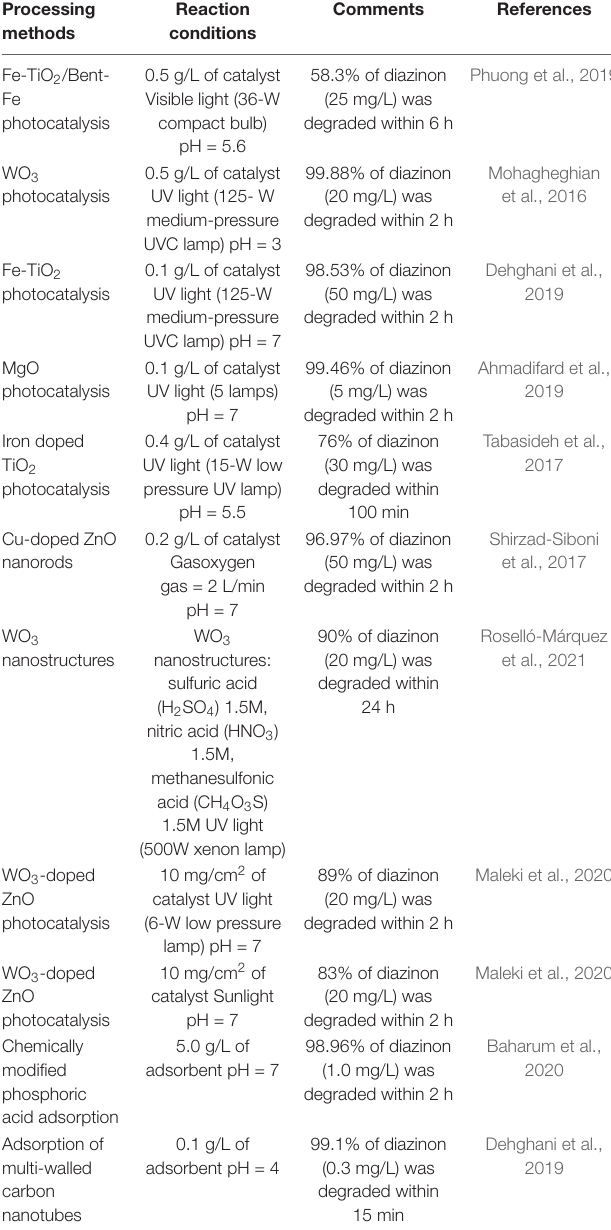
TABLE 2 | Physical and chemical methods for diazinon